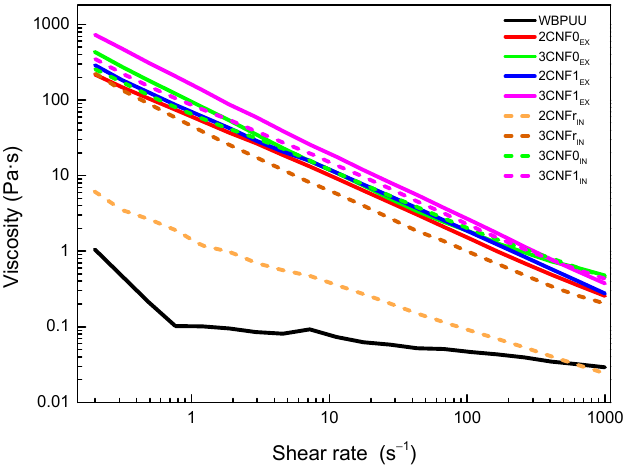
Figure 2. Viscosity flow curves of neat WBPUU and WBPUU/CNF inks. Table 2. Viscosity and rheological parameters for ex situ - and in situ -prepared WBPUU/CNF inks. Sample